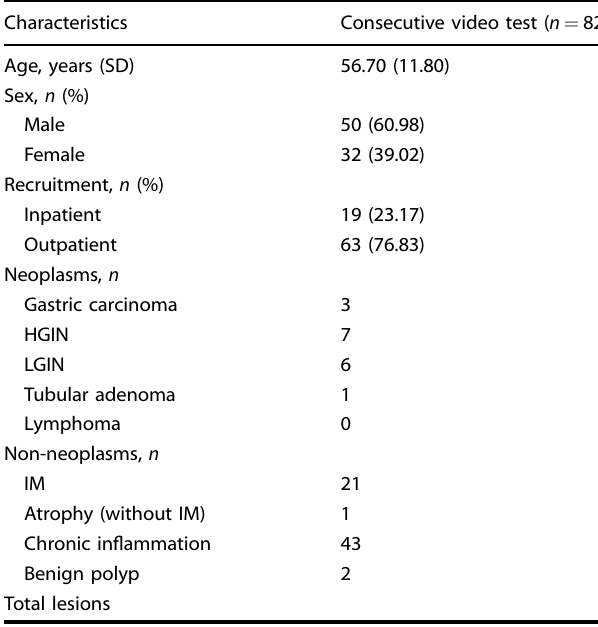
Fig. 2 Performance of ENDOANGEL-ED and endoscopists in the internal and external videos. A Internal videos. B External videos. Table 2. Patient and lesion characteristics in consecutive